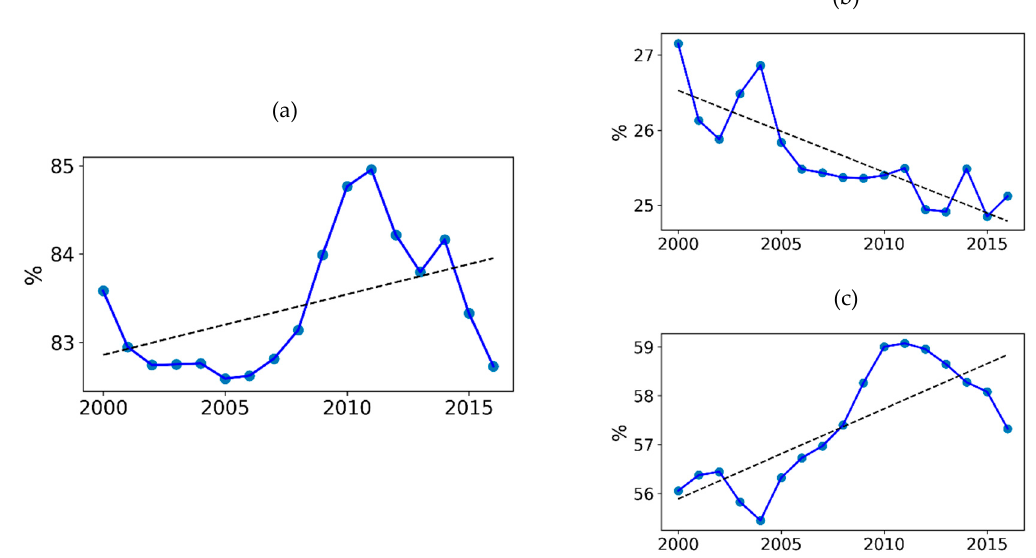
Figure 11. ( a ) Percentage average of forest average on 8 watersheds Amur River basin, ( b ) percentage Figure 11. (a) Percentage average of forest average on 8 watersheds Amur River basin, (b) percentage average of coniferous on 8 watersheds Amur River basin, ( c ) percentage average of broadleaf on 8 average of coniferous on 8 watersheds Amur River basin, (c) percentage average of broadleaf on 8 watersheds Amur River watersheds Amur River basin.